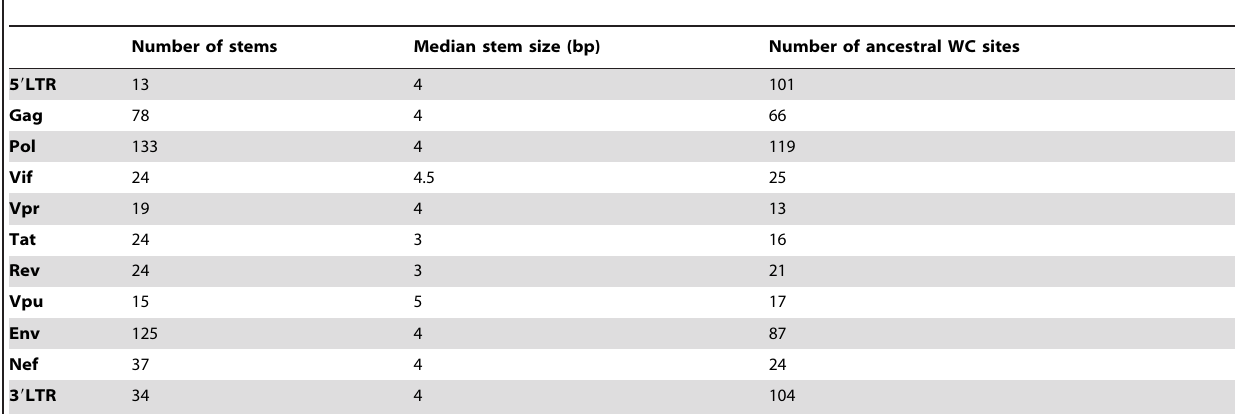
Table 1. Number of stems, median stem size, and number of ancestral WC sites in different regions of the HIV-1 genome.